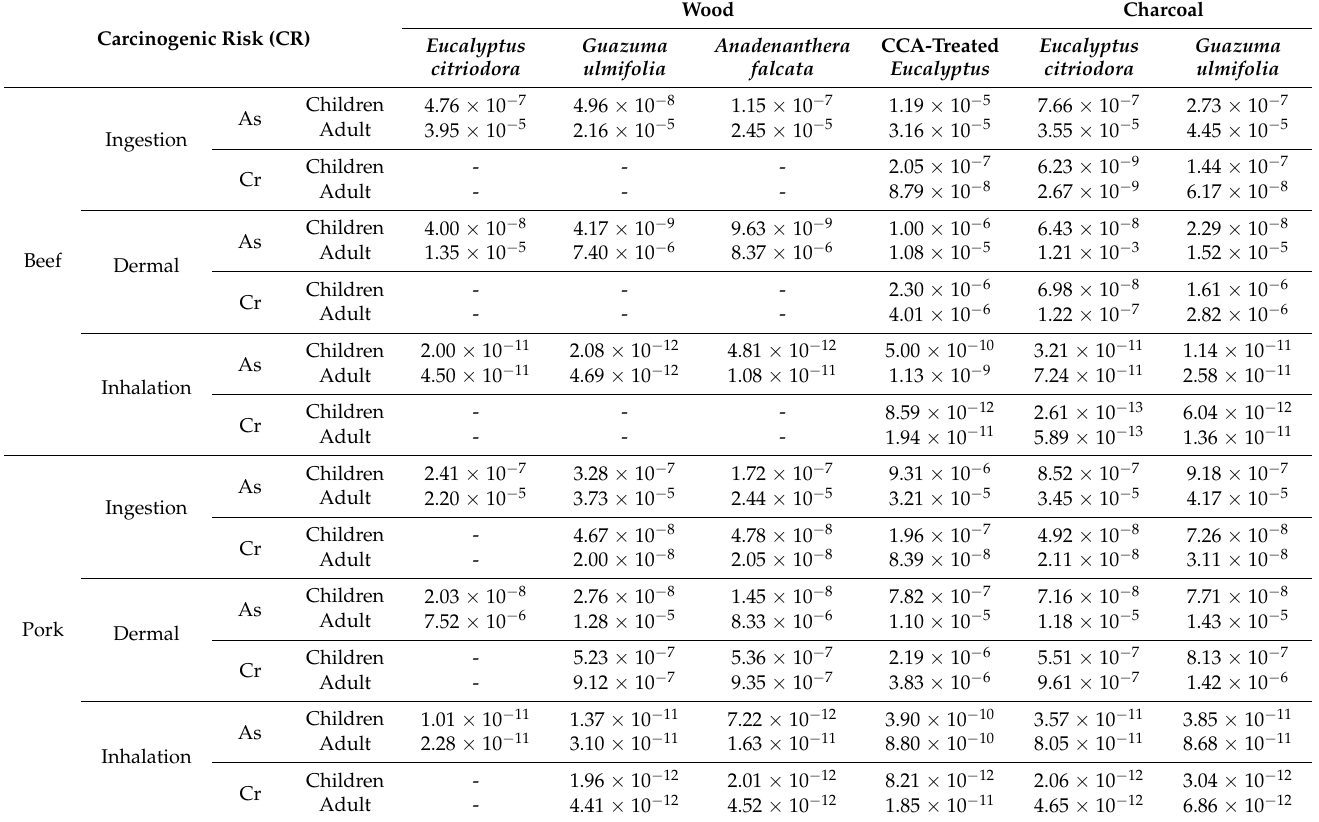
Table 6. Carcinogenic risks of each element for children and adults through inhalation, ingestion, and dermal